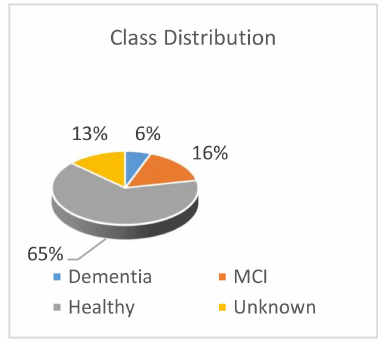
Figure 4. CASAS data class distribution of total